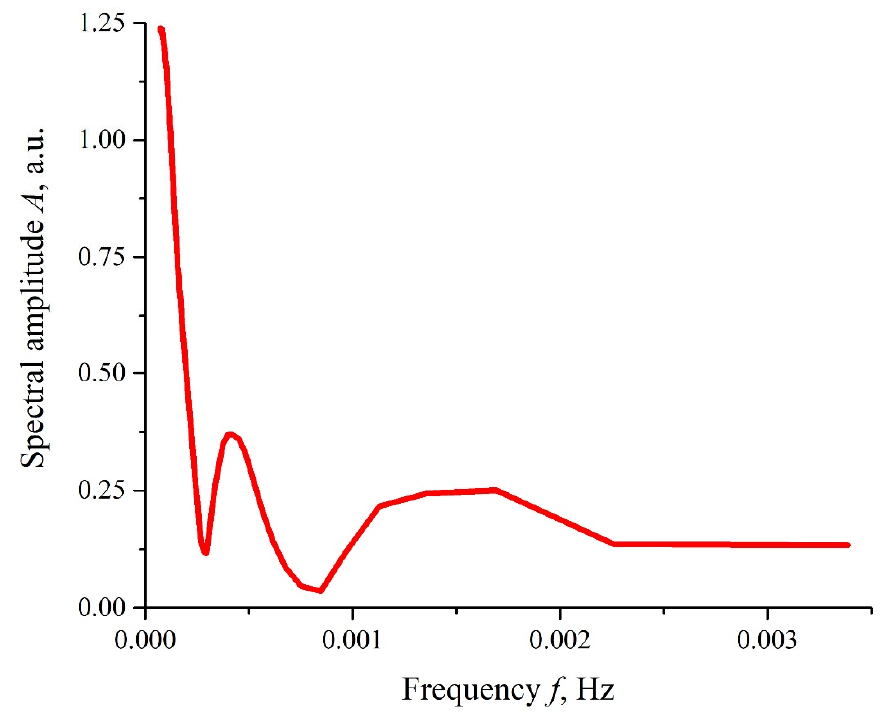
Figure 5. The frequency dependence of the spectral amplitude, A ( f ), for the I ( t ) plot shown in Figure 4b.